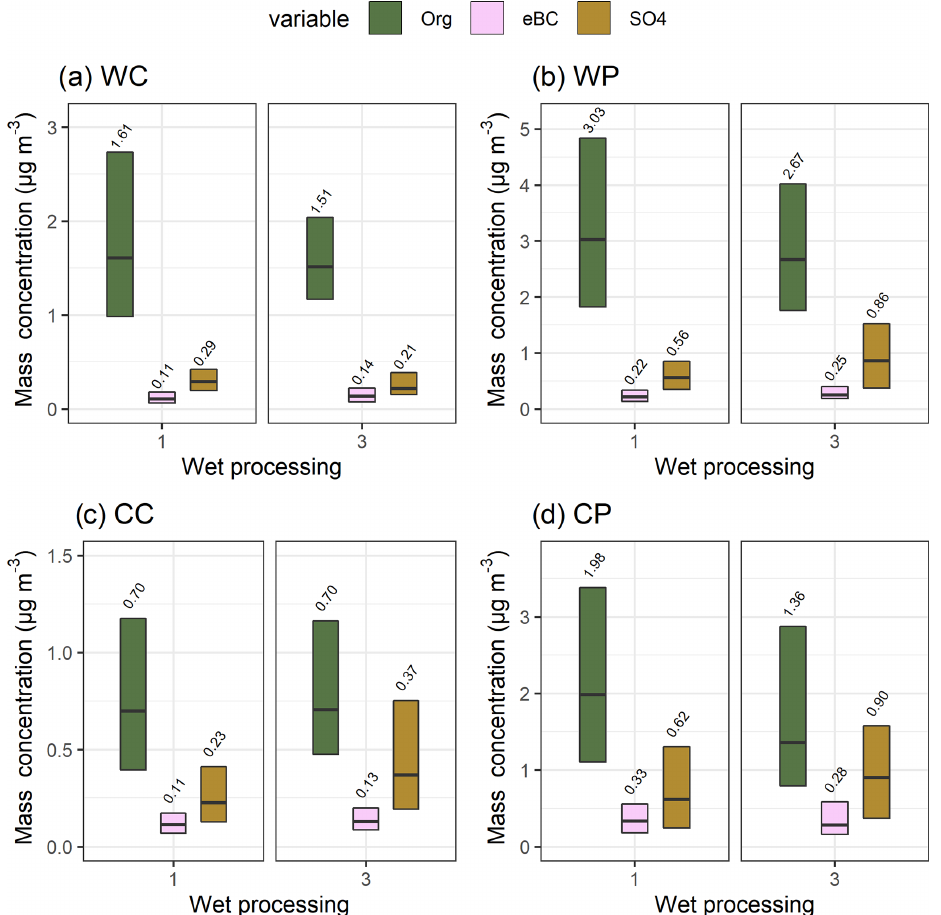
Figure 6. Median (black horizontal lines and numerical values) particle mass concentration with 25th–75th percentiles (boxes) for Org, eBC, and SO 4 for wet processing groups 1 and 3 as described in Table 1. Subplots show the air mass sectors (clean and polluted) with the seasonal (warm and cold) division: (a) warm and clean, (b) warm and polluted, (c) cold and clean, and (d) cold and polluted. The figure is based on simultaneous observations of these three species between March 2012 and August 2019. Note the different y -axis limits in each